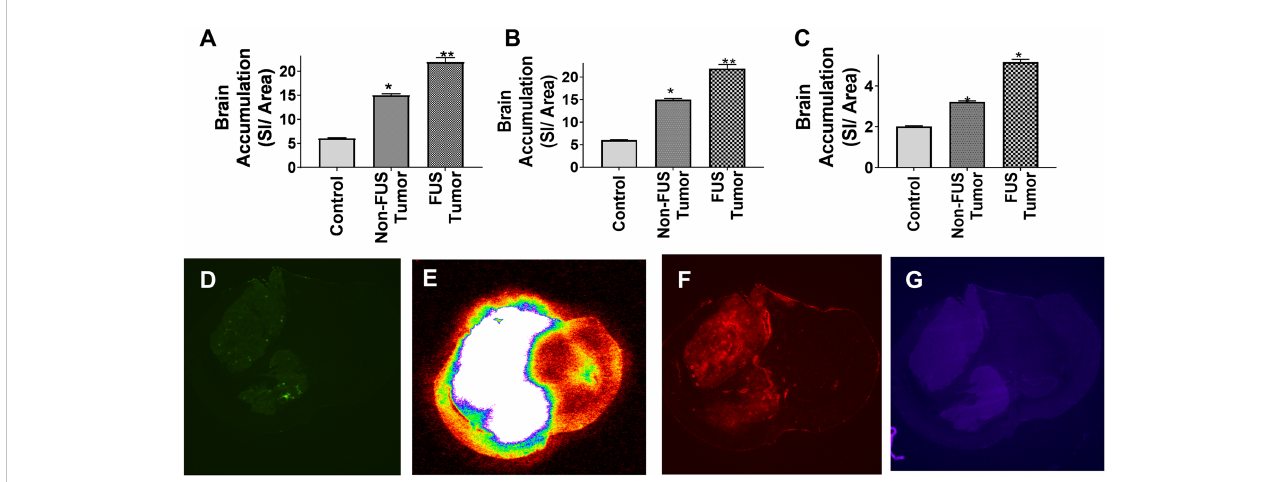
FIGURE 1 Permeability of metastatic brain lesions increases following LIFU mediated disruption. (A-C) BBB disruption with LIFU shows signi fi cantly higher accumulation of dye when the tumor region is disrupted by LIFU for AIB, TxRed and Cs Blue respectively. (p<0.0001) (D) GFP labeled tumor outline by fl uorescent imaging. (E-G) BBB disruption by LIFU visualized within tumor region by autoradiographic and fl uorescent imaging for AIB, TxRed and Cs Blue respectively. * p<0.01, **